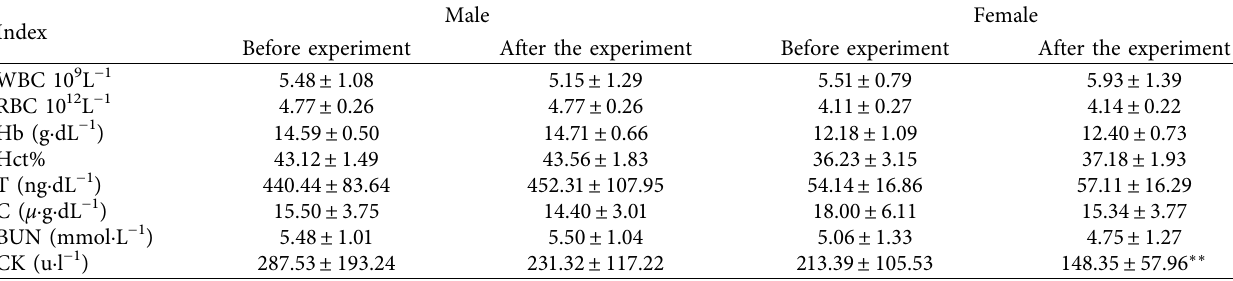
Table 3: Results of changes in biochemical indexes of physical function of athletes.